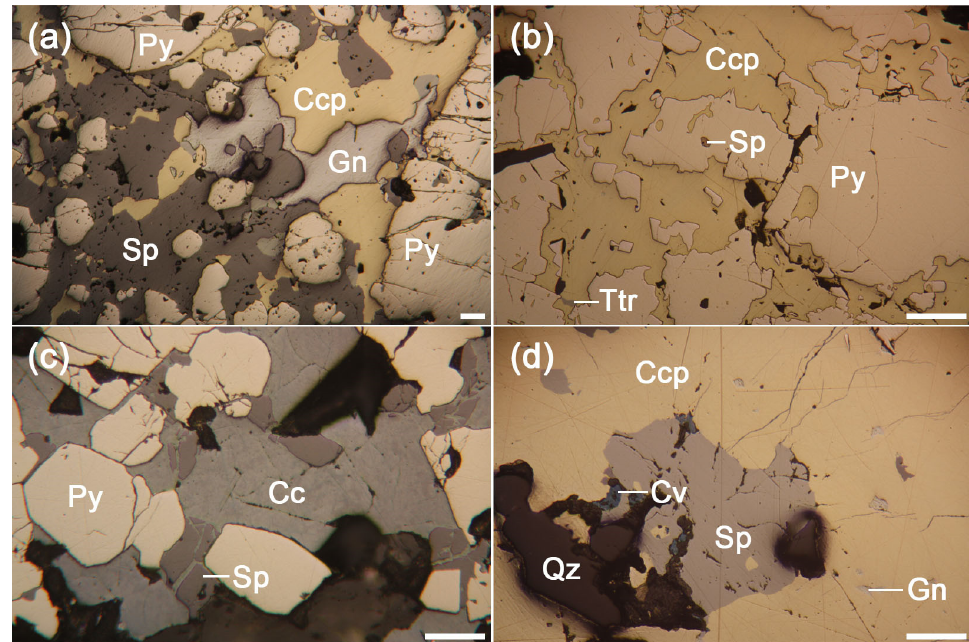
Figure 5. Plane-polarized reflected light photomicrographs of representative mineral assemblages from Mănăilă ore deposit: pyrite-polymetallic type with euhedral and subhedral grains of pyrite cemented and intergrowth with chalcopyrite, sphalerite, and galena; the cracks in the pyrite are filled with chalcopyrite ( a ); pyrite copper type, anhedral pyrite corroded and intergrowth with chalcopyrite; frequent inclusions of chalcopyrite and sphalerite in pyrite; and micrometric chalcopyrite veins in pyrite ( b ); pyrite-polymetallic type with euhedral and anhedral pyrite cemented by sphalerite and chalcocite; the sphalerite is brecciated and cemented by chalcocite ( c ); pyrite copper type, compact masses of chalcopyrite with inclusions of sphalerite, galena and quartz; the sphalerite is replaced by secondary covellite ( d ). Sp—sphalerite; Py—pyrite; Ccp—chalcopyrite; Gn—galena; Ttr—tetrahedrite; Qz—quartz; Cc—chalcocite; Cv—covellite. Scale bars on the photomicrographs are 100 μm.